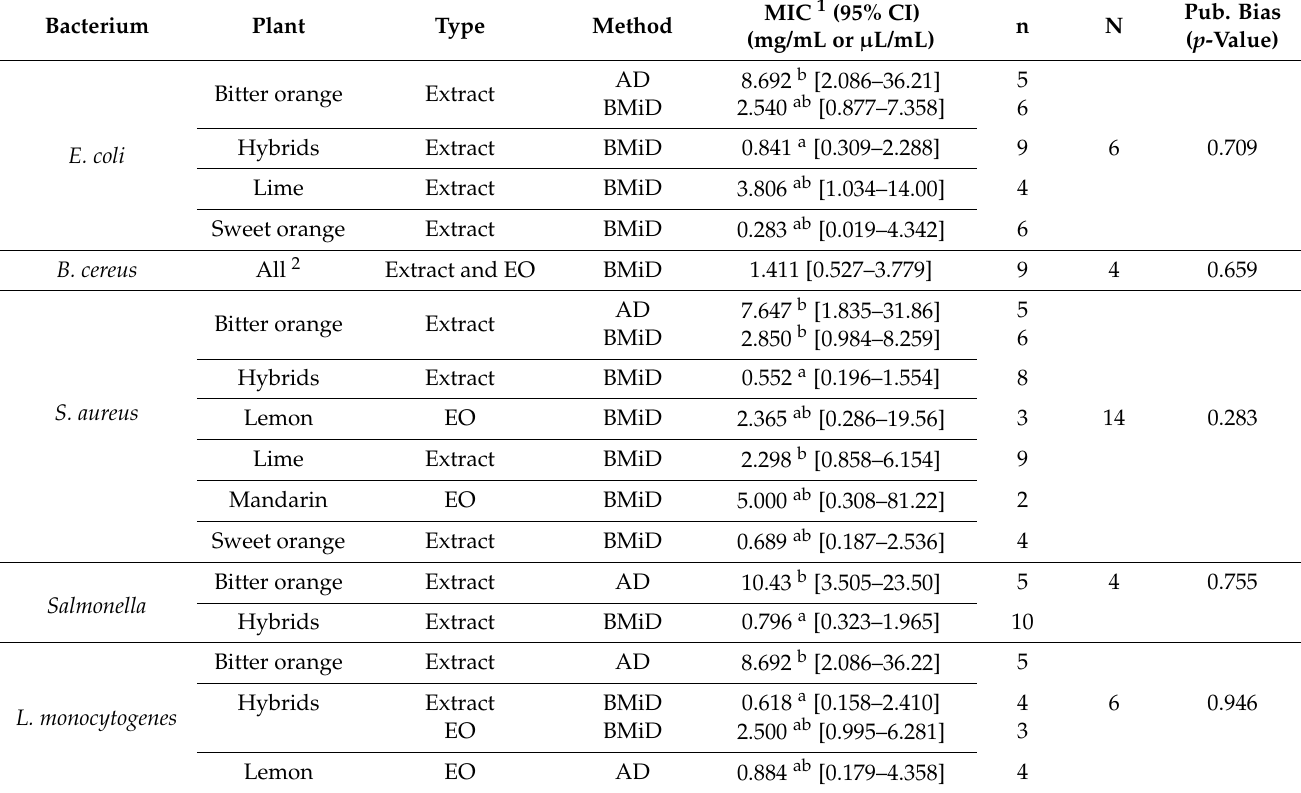
Table 4. Pooled MICs (mean and 95% confidence intervals, CIs) produced by extracts (in mg/mL) or EOs (in µ L/mL) of Citrus species by method of determination (agar dilution (AD) and broth micro-dilution (BMiD)), as estimated by meta-analysis models separately adjusted by bacterium. Number of observations (n), number of primary studies (N), and p -value of the publication bias test are displayed per meta-analysis